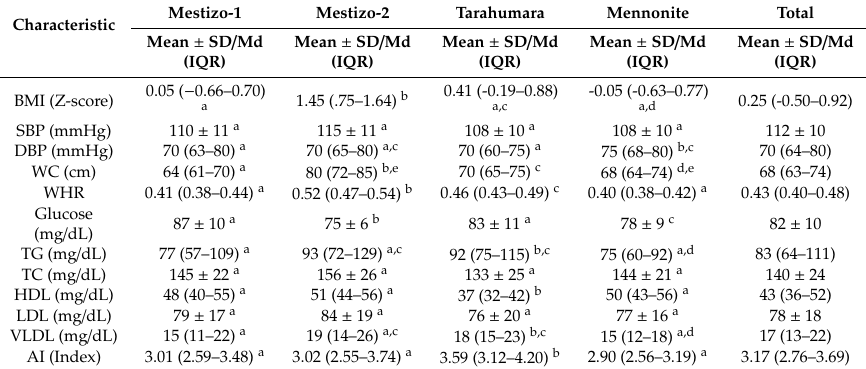
Table 2. Metabolic traits comparison among the studied